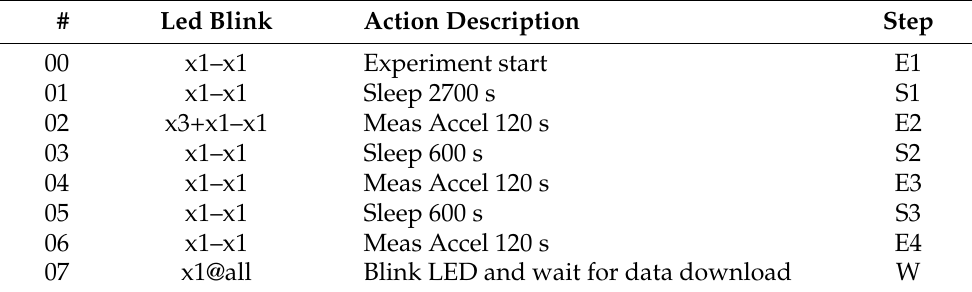
Table 3. Experiment program to evaluate the battery